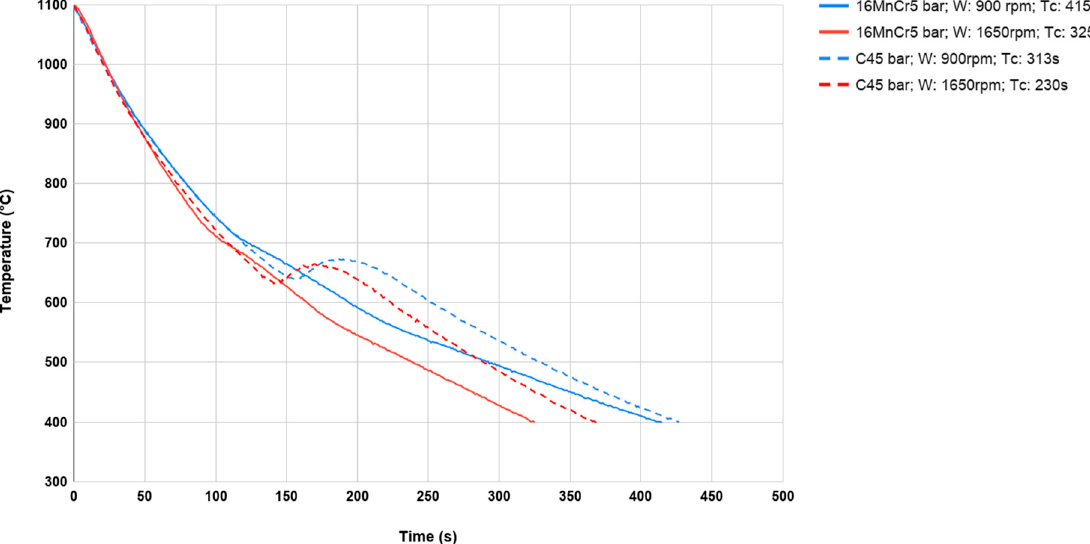
Figure 12. The cooling curves of 16MnCr5 and C45 samples with the dimensions ⌀ 35 × 20 mm with the ventilator speed of 900 rpm and 1650 rpm from forging temperature 1100 °C to 400 °C.